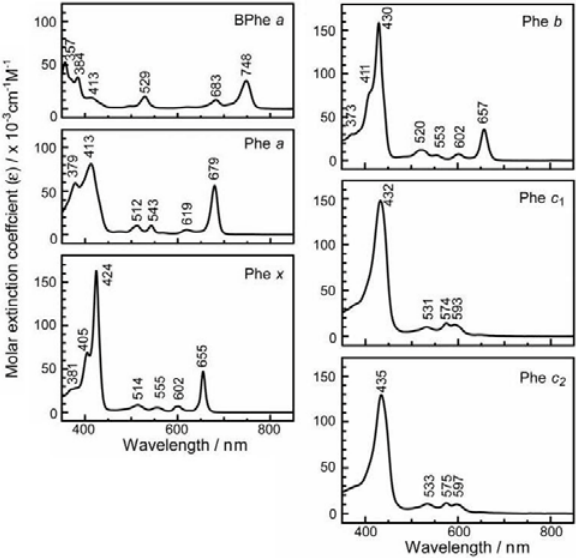
Figure 32. Electronic-absorption spectra of BPhe a , Phe a , Phe x , Phe b , Phe c in THF solution (reprinted with permission from [20] © 2008, American Chemical